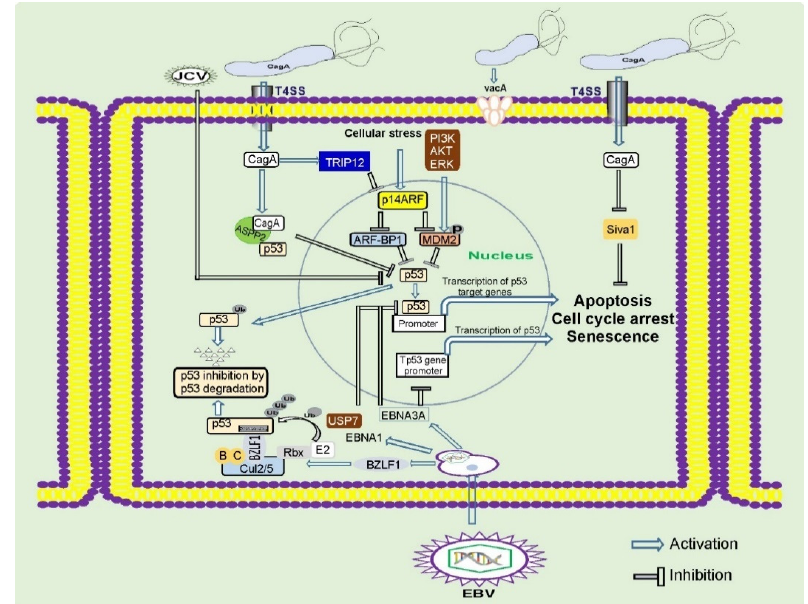
Figure 2. Regulation of tumor suppressor proteins by gastric pathogens. Gastric pathogens: H. pylori and oncogenic viruses inhibit key tumor suppressors proteins p53, p14ARF, and others. These events result in inhibition of the DNA damage and oncogenic stress responses, two key mechanisms important for prevention of gastric